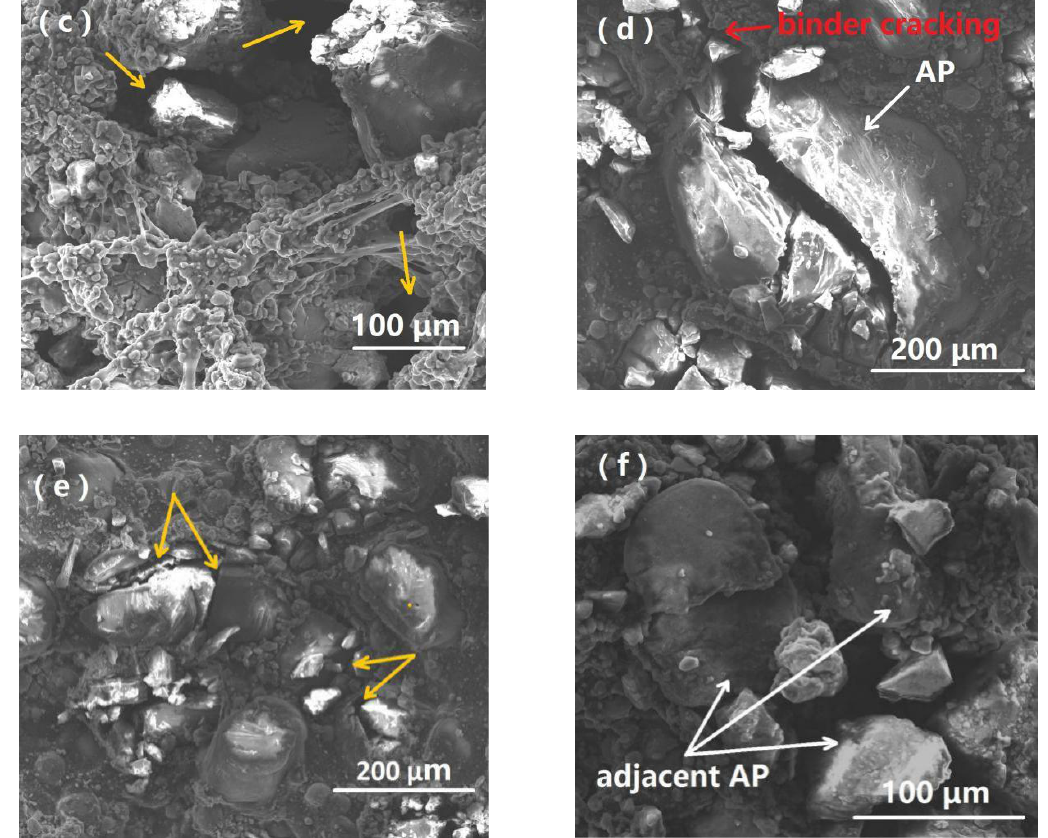
Figure 9. SEM micrographs of the fractured H-80W after SHPB testing at room temperature under a strain rate of 6100 s − 1 : ( a ) cracking of AP particle and pieces of broken AP spreading on the fracture surface; ( b ) individual cracking AP particle without direct contact with other particles; ( c ) the multiple porosity and binder matrix tearing induced by high-speed impact loading; ( d ) cracking propagating through binder matrix into AP particles; ( e ) cracking propagating through the AP particle-binder interface into the AP particles; ( f ) cracking propagating through the adjacent AP particles.